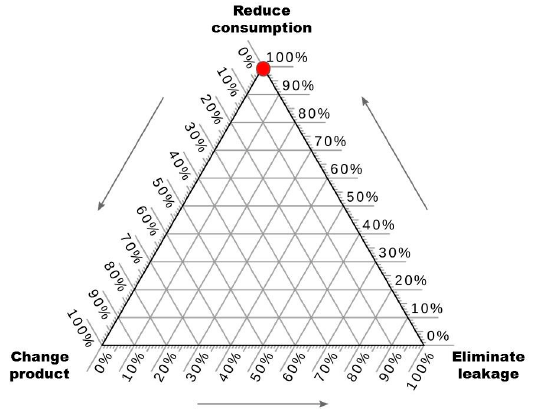
Figure 1. Driving solely a product ban approach.